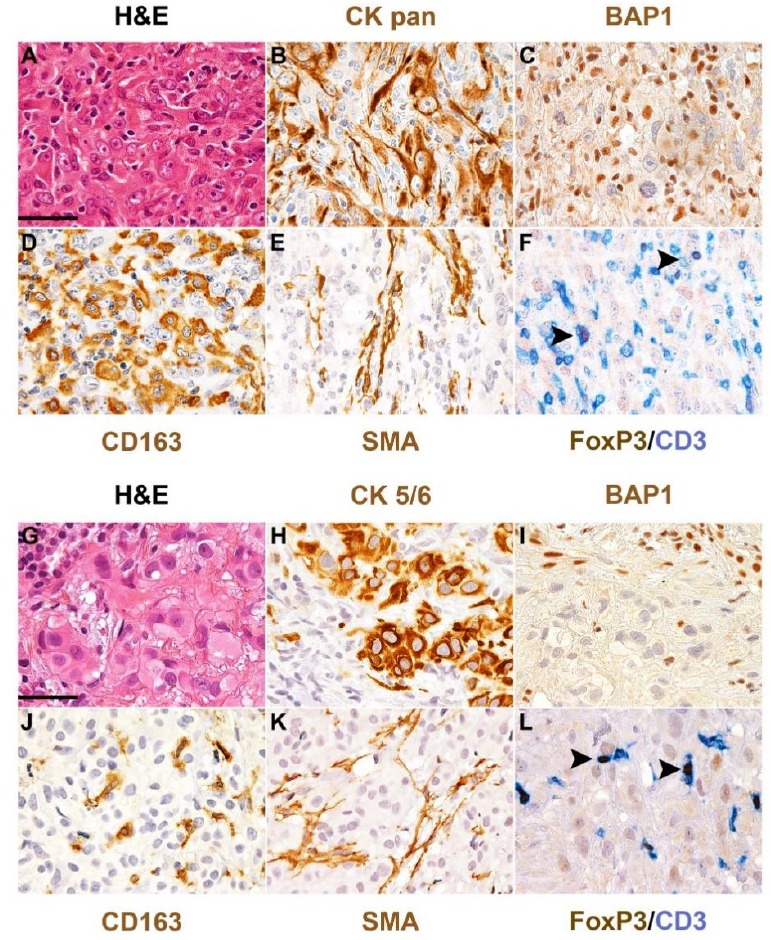
Figure 1. BAP1 loss and microenvironment in human mesothelioma. Hematoxylin and eosin stain and a set of immunostainings performed on formalin-fixed paraffin-embedded sections of two cases of human epithelioid mesothelioma of the pleura showing loss of BAP1. The upper case ( A – F ) results massively infiltrated by CD163 + macrophages, SMA + fibroblasts and CD3 + T-cells including the FOXP3 + regulatory population, whereas the bottom case ( G – L ) displays a scant macrophage infiltration. Primary antibodies included broad-spectrum cytokeratin (CK, B ) or cytokeratin 5/6 ( H ) as mesothelioma markers; anti-BAP1 ( C , I ); CD163 ( D , J ), for tumor-associated macrophages (TAMs); smooth muscle actin (SMA, E , K ) for cancer-associated fibroblasts (CAFs); CD3 ( F , L ) for T-cells and FoxP3 for regulatory T-cells. Arrows ( F , L ) highlight representative regulatory T-cells. Original magnification 400 × , scale bar 50 µ